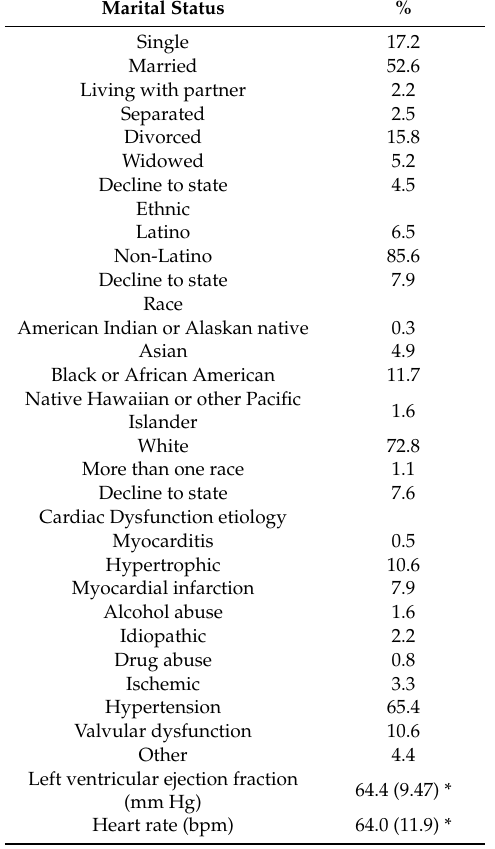
Table 1. Basic sociodemographic and clinical data of the patient sample.